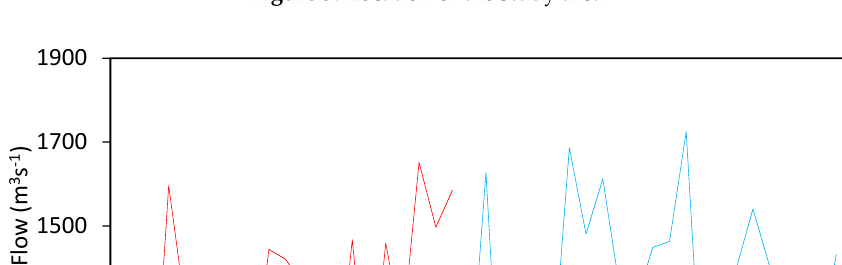
Figure 3. Location of the study area.